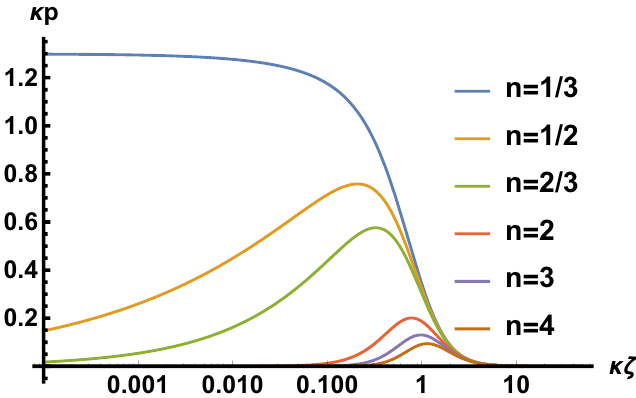
Figure 1 . We illustrate the pro(cid:12)le function (2.9) for various choices of n , while keeping m = 2 and Q f = 1 (cid:12)xed. The value of n increases as gazing curves from top to bottom. The pro(cid:12)le peaks at some O (1) radial coordinate, which will be indicated in the coming (cid:12)gures with asterisk